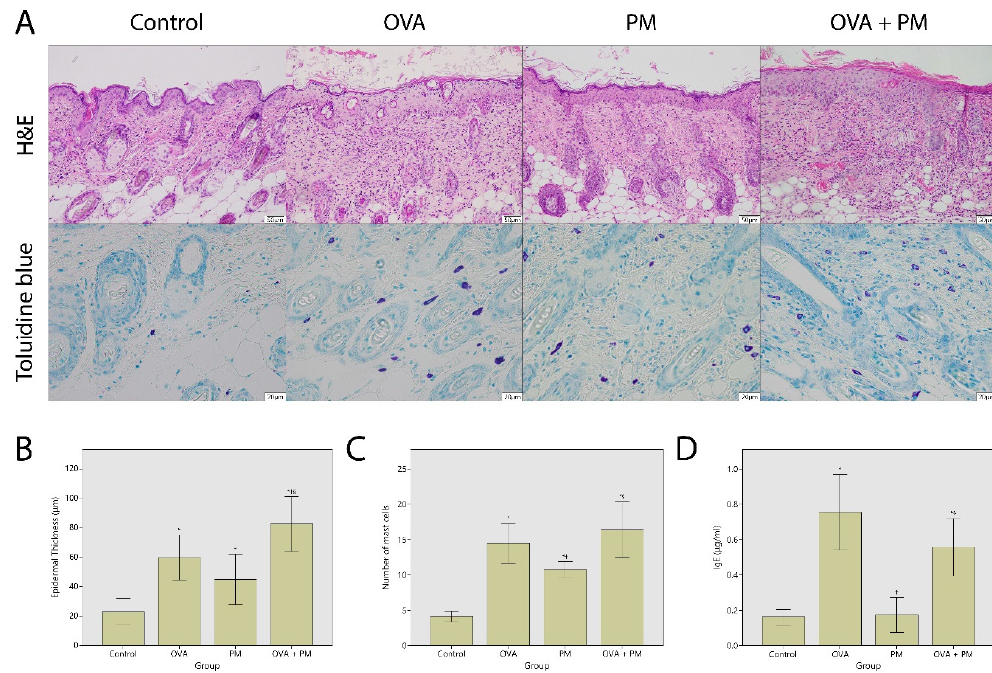
Figure 2. ( A ) (upper) Histologic effects of ovalbumin (OVA) and particulate matter (PM) 10 on the back skin of mice (hematoxylin and eosin (H&E); ×100), (lower) mast cell infiltration following OVA and PM 10 exposure (toluidine blue; ×400). ( B ) Epidermal thickness. ( C ) The number of mast cells in five randomly chosen high power fields at ×400 magnification. ( D ) Serum IgE. * p < 0.05 compared to control, † p < 0.05 compared to OVA, § p < 0.05 compared to PM 10 . As shown in Figure 2A, OVA and PM 10 increased mast cell infiltration in the dermis. The mast cell number was significantly higher in the OVA group (14.5 ± 3.04/5 high power fields) and the PM group (10.7 ± 1.10), compared to control (4.17 ± 0.72) ( p < 0.01). The number of mast cells in OVA